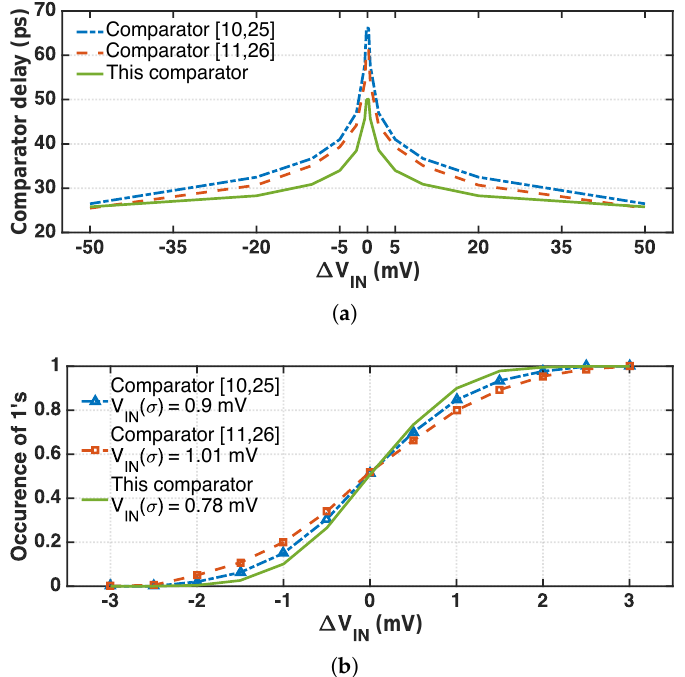
Figure 5. Simulated delay versus Δ V IN for the same offset/noise ( a ) and cumulative noise distribution for similar delay ( b ) for [10,11,25,26] and the proposed design.